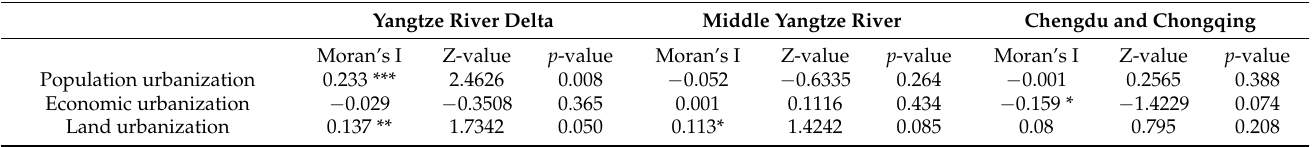
Table 5. Global bivariate spatial autocorrelation analysis of urbanization and WEF. Yangtze River Delta Middle Yangtze River Chengdu and Chongqing Moran’s I Z-value p -value Moran’s I Z-value p -value Moran’s I Z-value p -value Population